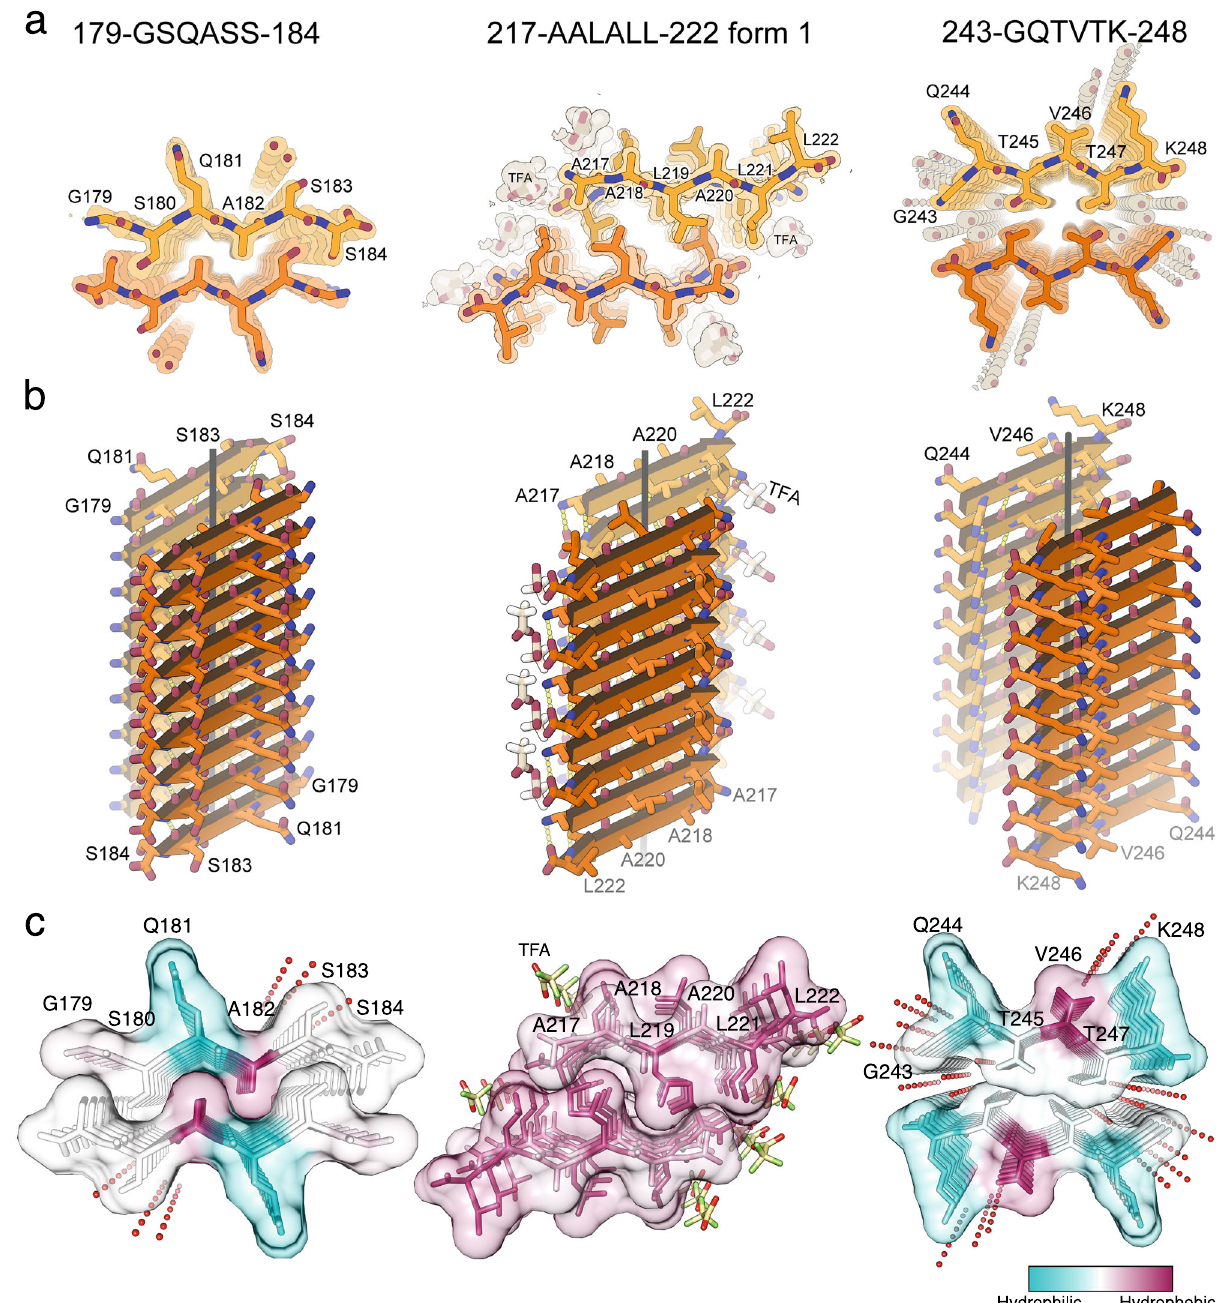
Fig. 4 | Atomic structures of amyloid-like association of NCAP segments revealed by crystallography. a Quality of the fi t of each atomic model to its corresponding simulated annealing composite omit maps 92 . The maps are con- toured atthe 1.0 sigma level.All structuralfeatures are wellde fi ned by the density. Theviewisdownthe fi brilaxis.Eachchainshownherecorrespondstoonestrandin a β -sheet. Thousands of identical strands stack above and below the plane of the page making ~100 micron-long β -sheets. The face of each β -sheet of AALALL (PDB 7LTU) [https://doi.org/10.2210/pdb7LTU/pdb] (form 1) is symmetric with its back. However, GSQASS (PDB 7LV2) [https://doi.org/10.2210/pdb7LV2/pdb] and GQTVTK (PDB 7LUZ) [https://doi.org/10.2210/pdb7LUZ/pdb] each reveal two dis- tinct sheet – sheet interfaces: face-to-face and back-to-back. The tighter associated pairofsheetsisshowninthis fi gure. b 18strandsfromeachofthestericzippersata